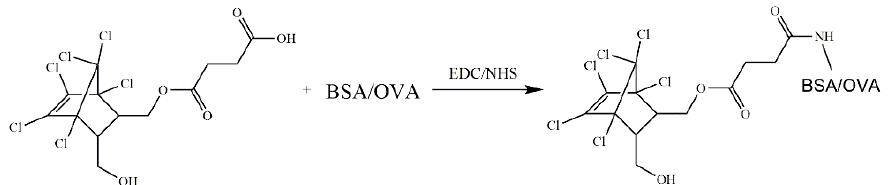
Figure 2. Synthesis of the immunogen antigen and coating antigen of endosulfan.